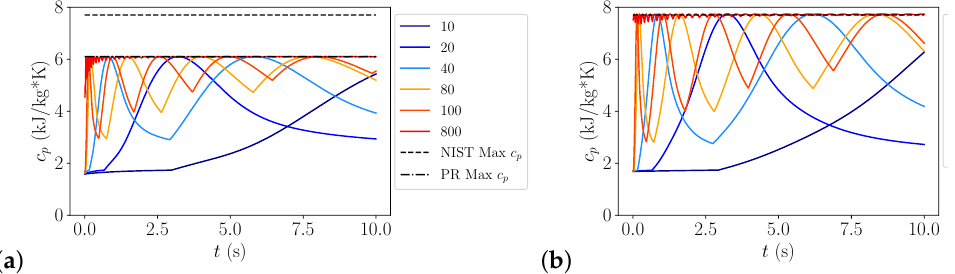
Figure 15. Plots of the maximum heat capacity versus time for O 2 at 7.0 MPa in 1D mixing simulation using Peng–Robinson fluid properties ( a ) and ANN fluid properties ( b